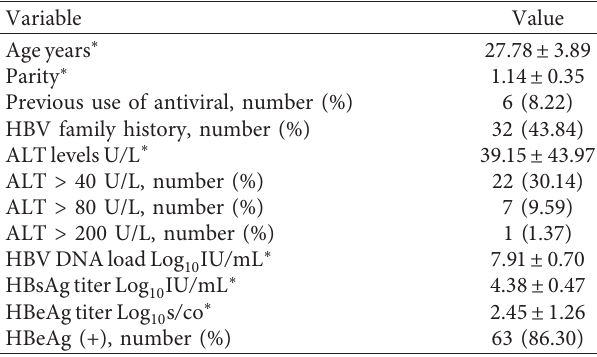
Table 1: Demographics and baseline characteristics.